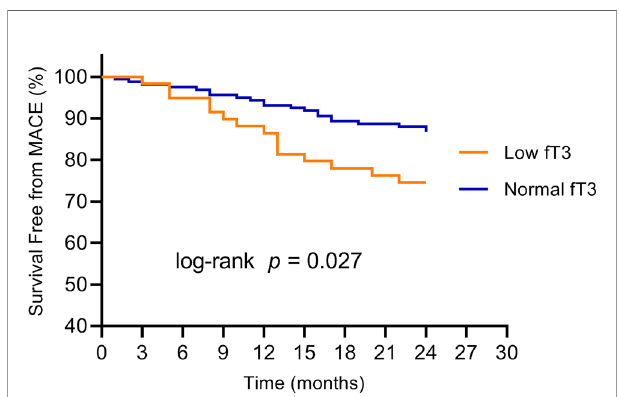
FIGURE 3 | Kaplan-Meier survival curves for MACE in MINOCA patients with low fT3 versus normal fT3 levels. fT3, free triiodothyronine; MACE, major adverse